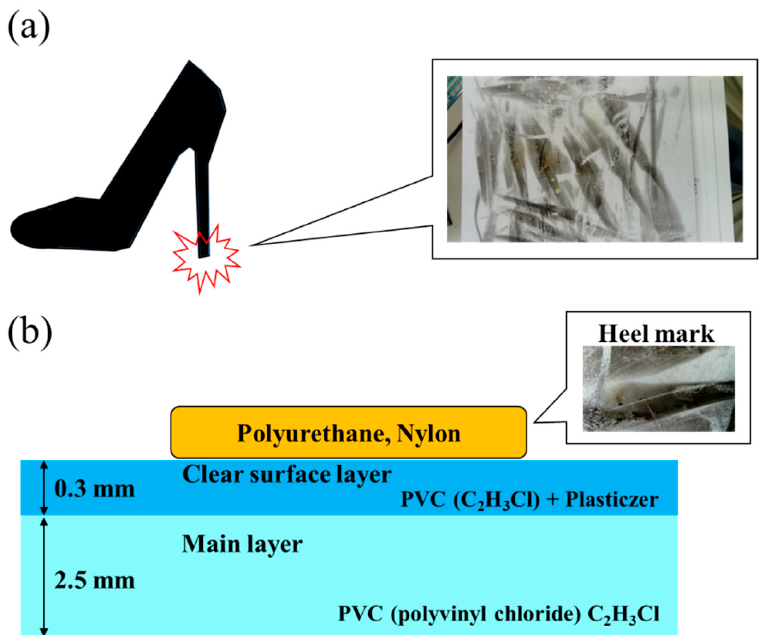
Figure 1. Typical stain examples. ( a ) HMs are produced by scratching or scrubbing a shoe sole on the floor tiles. ( b ) The cross-sectional structure of a sample floor tile showing the HM, clear surface layer, and main